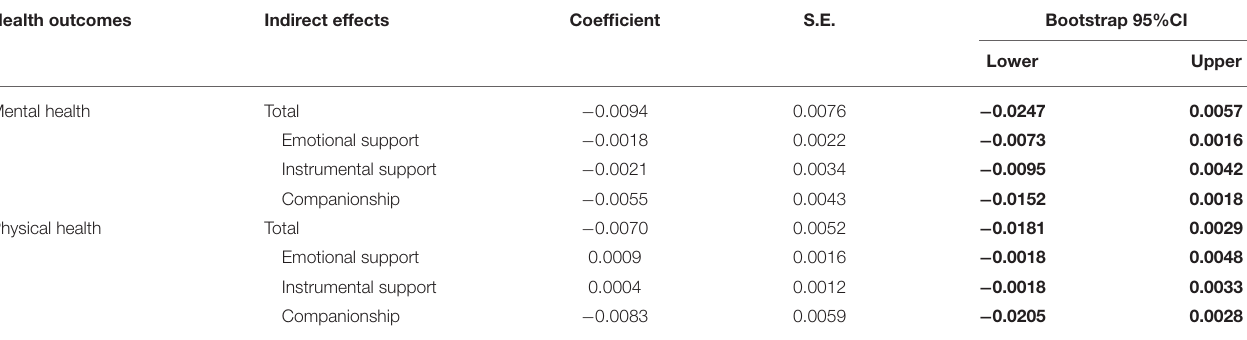
TABLE 6 | Mediation effects of the subtypes of social support in the association between widowhood and health status in the urban subsample ( N = 4,198).